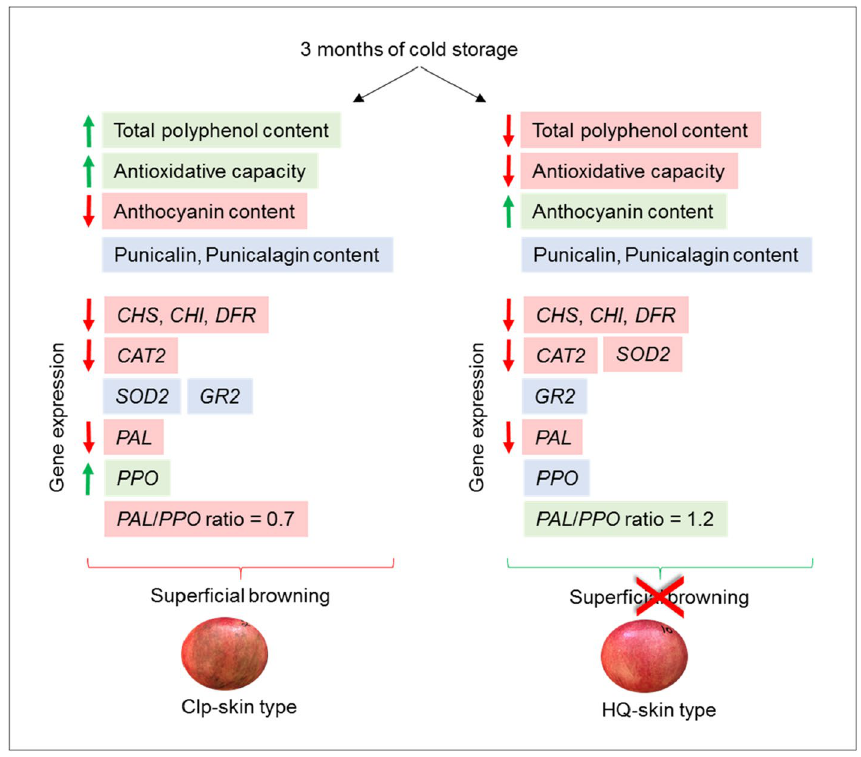
Figure 7. Schematic presentation summarizing the factors involved in promoting chilling injury of the pomegranate peel (CIp). The content of total polyphenols, anthocyanins, punicalin and punicalagin, and antioxidative capacity were compared between premature (PM) skin type that is susceptible for superficial browning and mature (M) skin (Figs. 3, 4, 5 and supplementary Figure S3). Up- and downregulation of genes expression was determined by comparing their level at harvest and following 3 month of storage in PM and M skin types (Fig. 6). Red background represents reduced level; green, induced level; blue, no significant change. Data suggests that high total polyphenol content and low anthocyanins level together with low value for PAL / PPO ratio promote